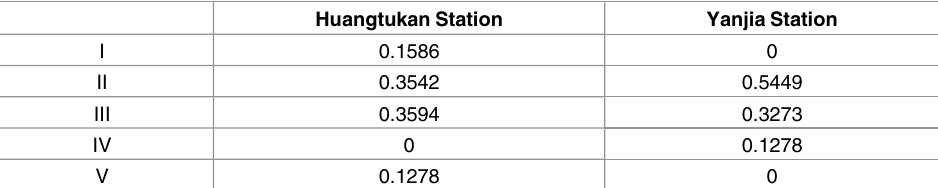
Table 10. Calculation results of